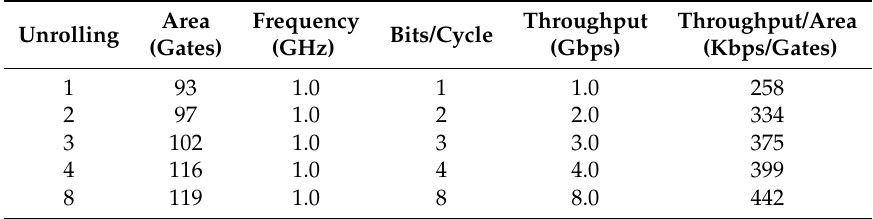
Table 3. MICKEY-128 2.0 synthesis results for highest frequency (65 nm).